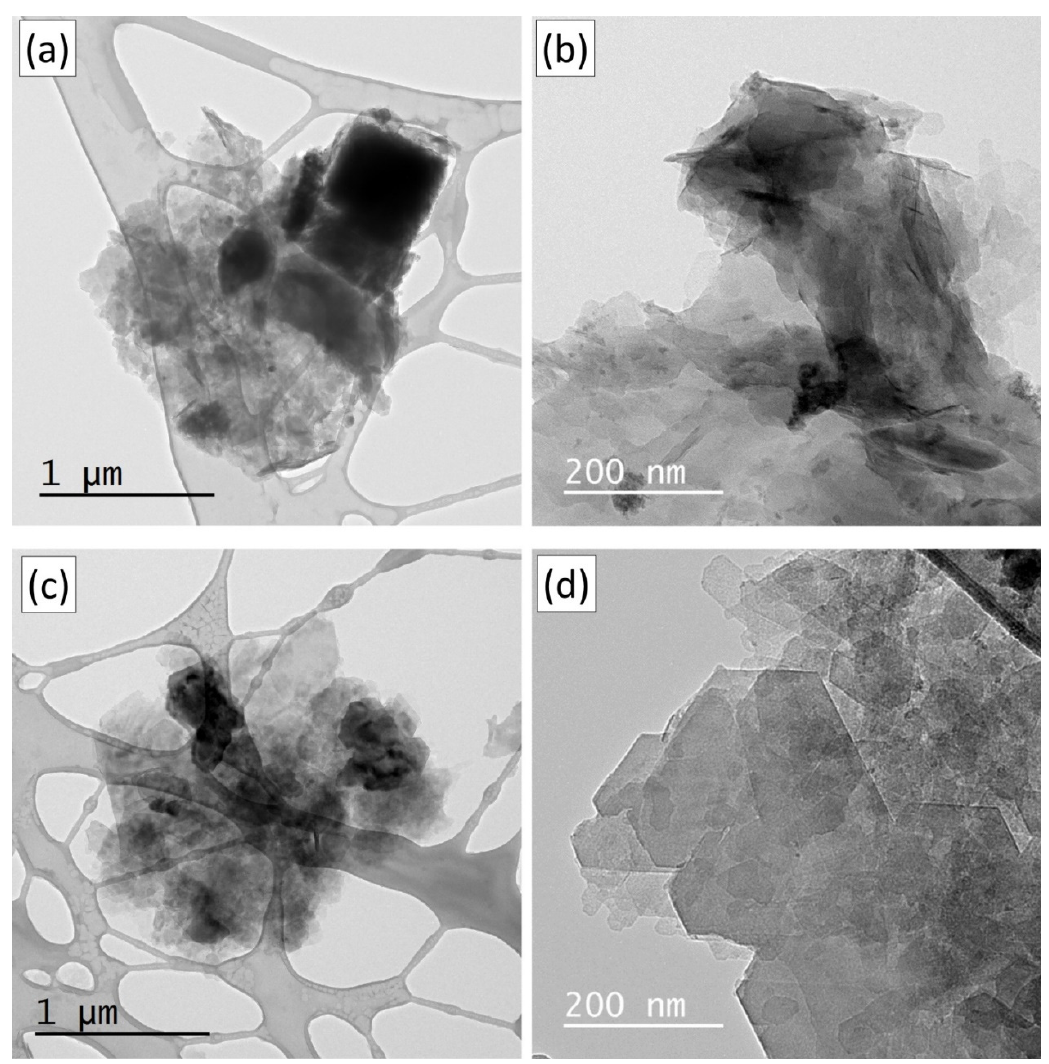
Figure 6. TEM images of ( a , b ) biwettable and ( c , d ) hydrophilic coarse clay aggregates at di ff erent magnifications.